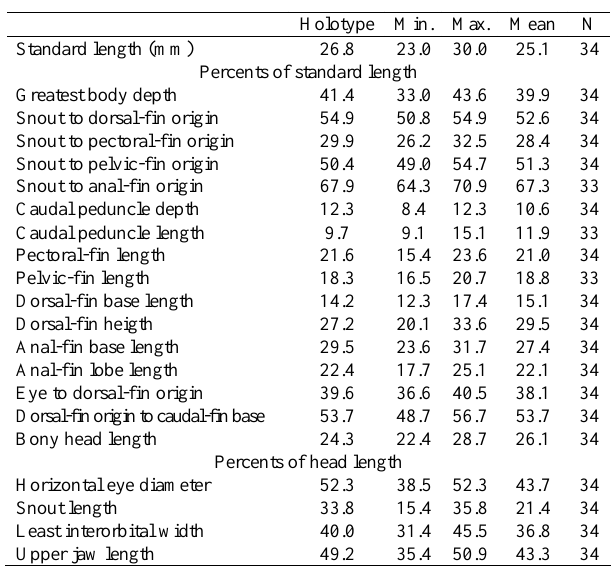
Table 1. Morphometric data of holotype and paratypes of Hemigrammus arua . Standard length (SL) is expressed in mm, all other measurements are expressed as percentages of SL, except for subunits of head that are expressed as percentages of head length (HL). N includes holotype.